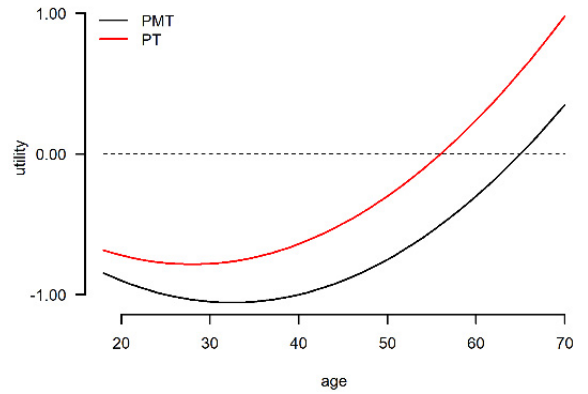
Figure 6. Example of a choice task.